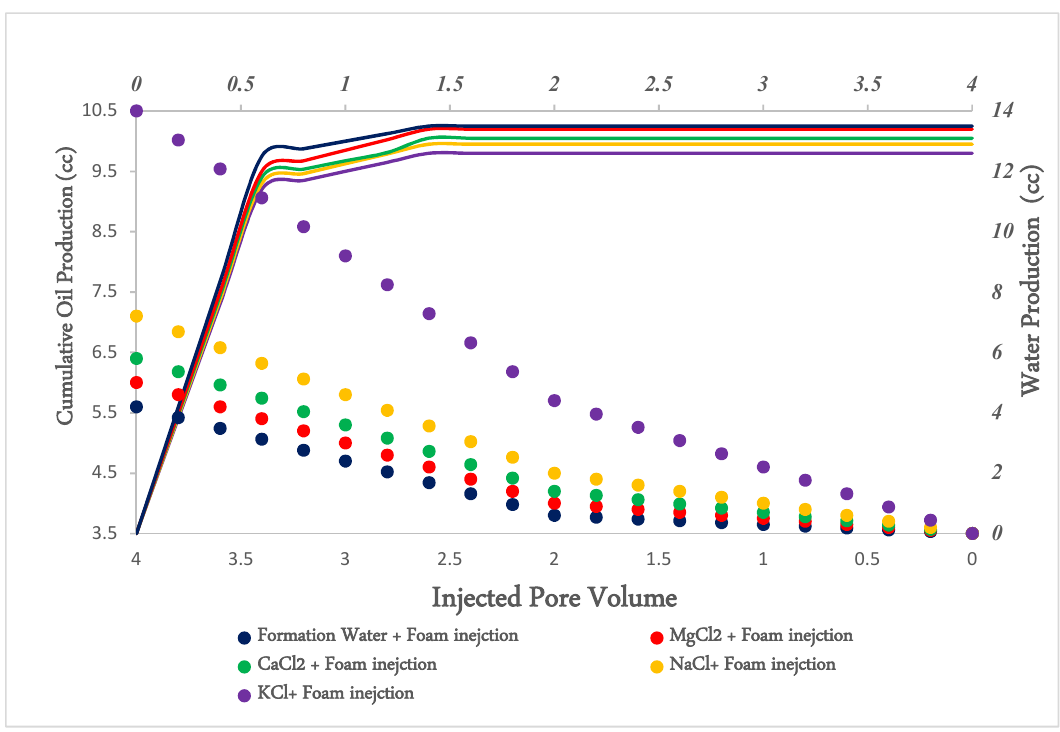
Figure 3. Cumulative oil and water production for different brine components.